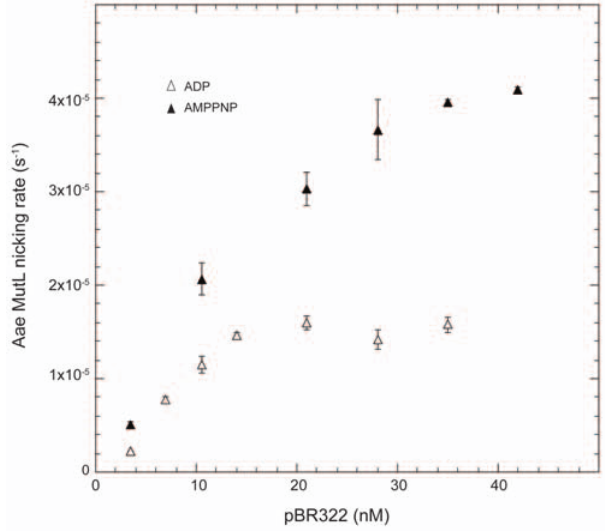
Figure 4. Influence of AMPPNP and ADP on the Aae MutL nicking rate. Initial rates of Mn ++ induced nicking activity of MutL were measured in the presence of AMPPNP (solid triangles) or ADP (open triangles) at 37 u C. Reaction time points were taken every 10 seconds for 2 minutes to determine the initial nicking rate. The initial rates were plotted against the concentration of the plasmid present in the reaction. Individual points are the average of 3 separate reactions.